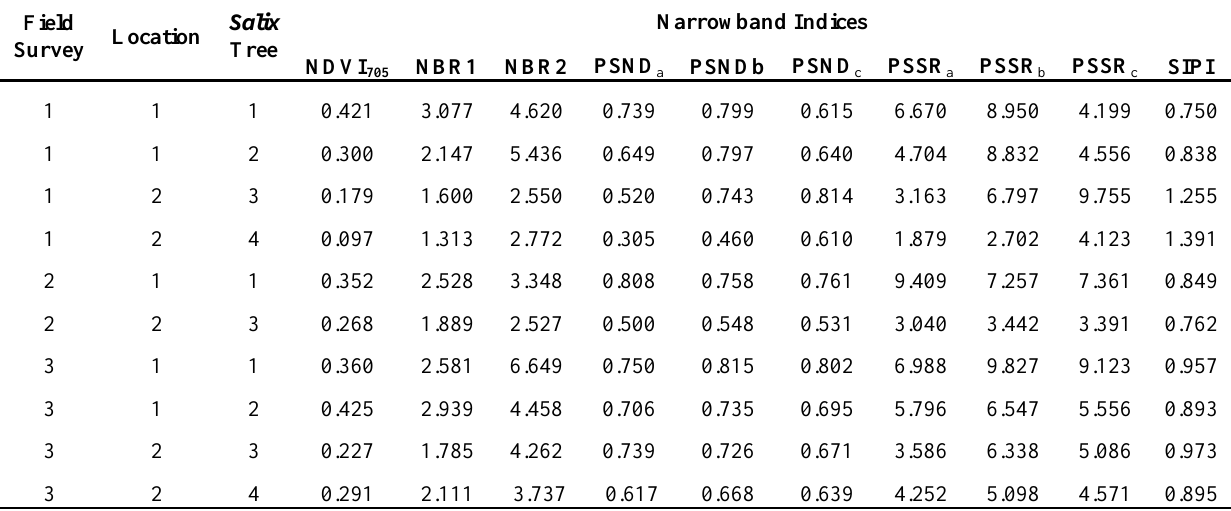
Table 2. Narrowband vegetation indices.